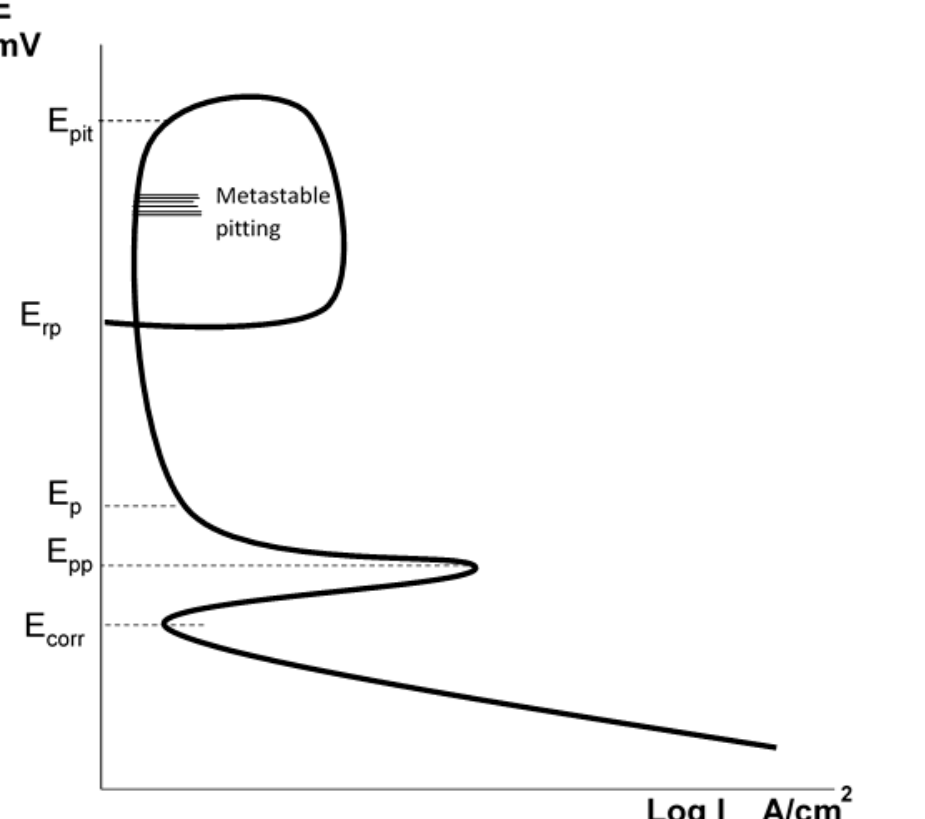
Figure 1. Schematic polarization curve: E pit pitting potential; E rp repassivation potential; E pp primary passive potential; E p passive potential; E corr corrosion potential.